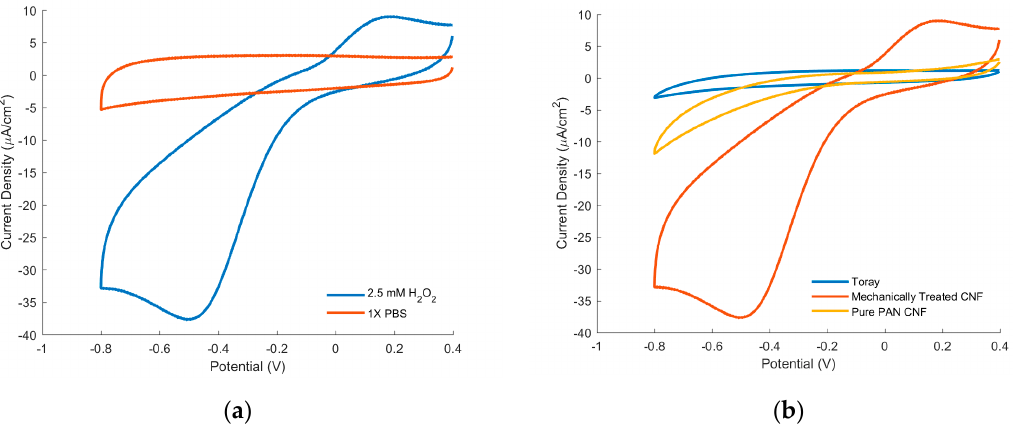
Figure 5. Cyclic voltammograms at 50 mV/s of ( a ) Mechanically treated CNF run in blank 1X PBS and in the presence of 1X PBS in the presence of 2.5 mM H 2 O 2 ; ( b ) Toray, Mechanically Treated CNF, and pure PAN CNF electrodes in 1X PBS in the presence of 2.5 mM H 2 O 2.